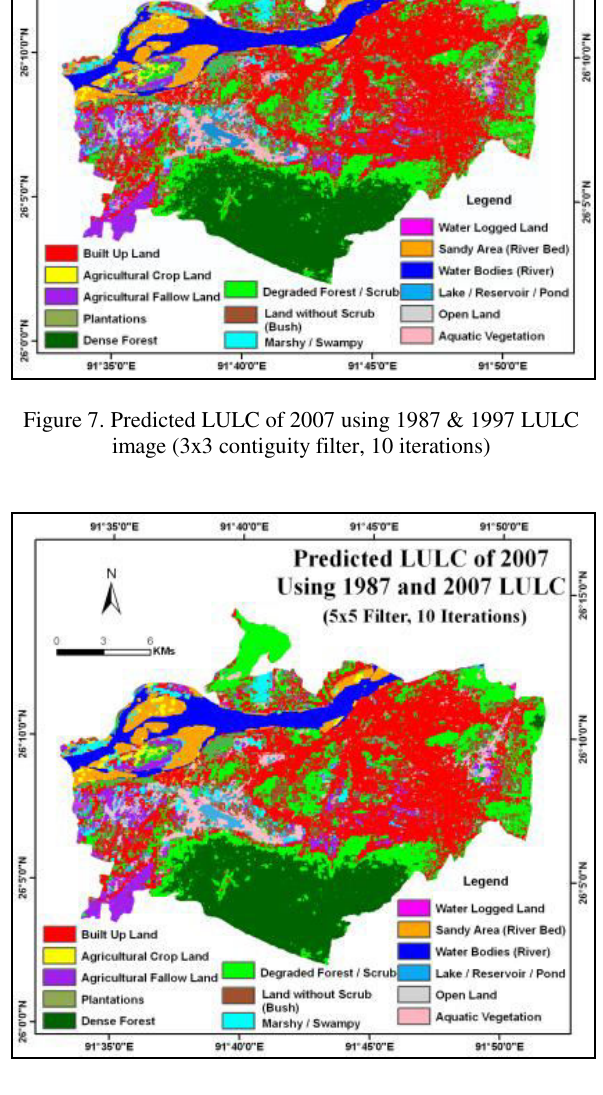
Figure 8. Predicted LULC of 2007 using 1987 & 1997 LULC image (5x5 contiguity filter, 10 iterations)